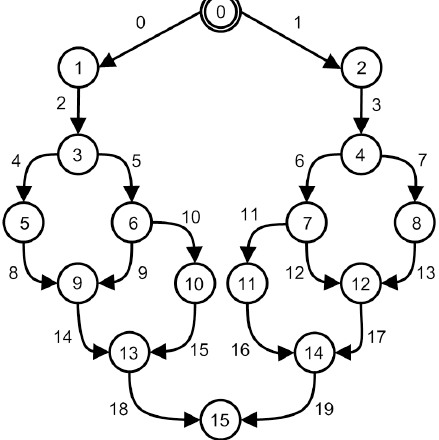
Fig. 6. Task graph with five levels of